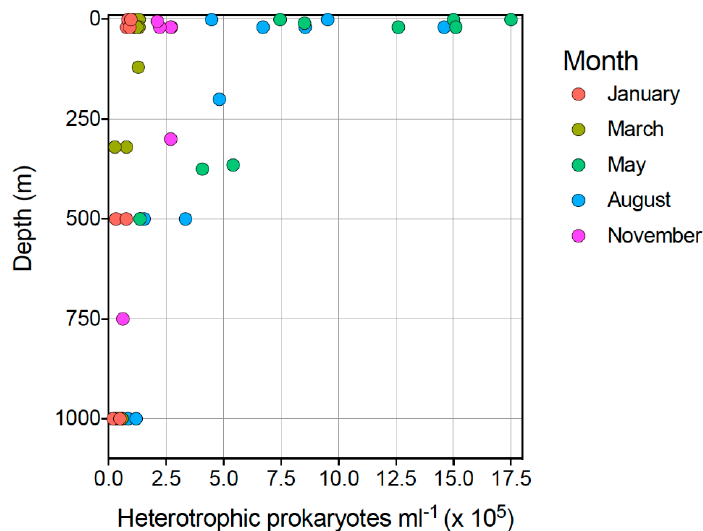
Figure 3. Scatterplot showing abundances of heterotrophic prokaryotes (HPs) as determined by flow cytometric enumeration. Depth (m) is shown on the y axis. Sampling months are represented with different colors. Note logarithmic x